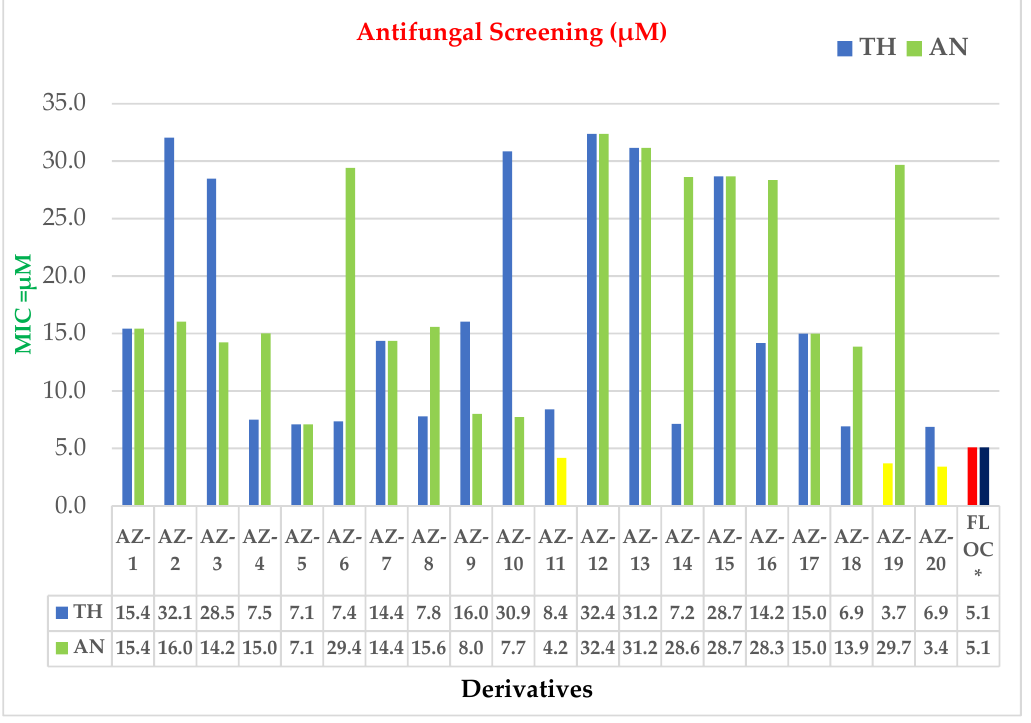
Figure 5. Antifungal screening of (substituted)-1,3,4-oxa/thia-diazol-2-yl)-3-chloro-4-(substituted) azetidin-2-one derivatives. *-Standard drug.